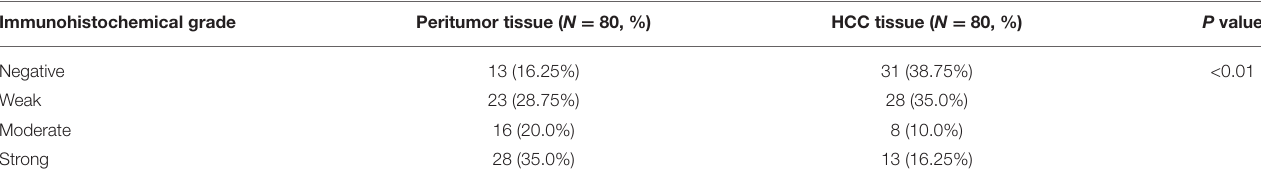
TABLE 1 | The expression level of NTF3 in HCC and adjacent peritumor